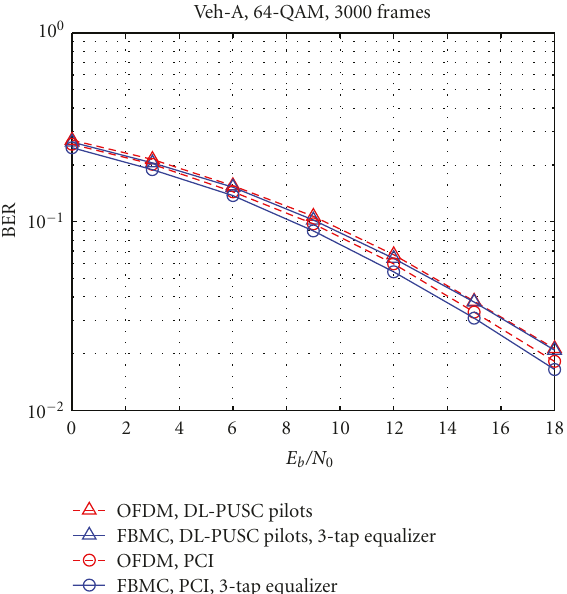
Figure 6: Comparison between OFDM-based WiMAX and FBMC- based WiMAX with 3-tap equalizers with respect to E b /N 0 . 64-QAM transmission with perfect channel information (PCI) and pilot- based estimation in a quasistatic